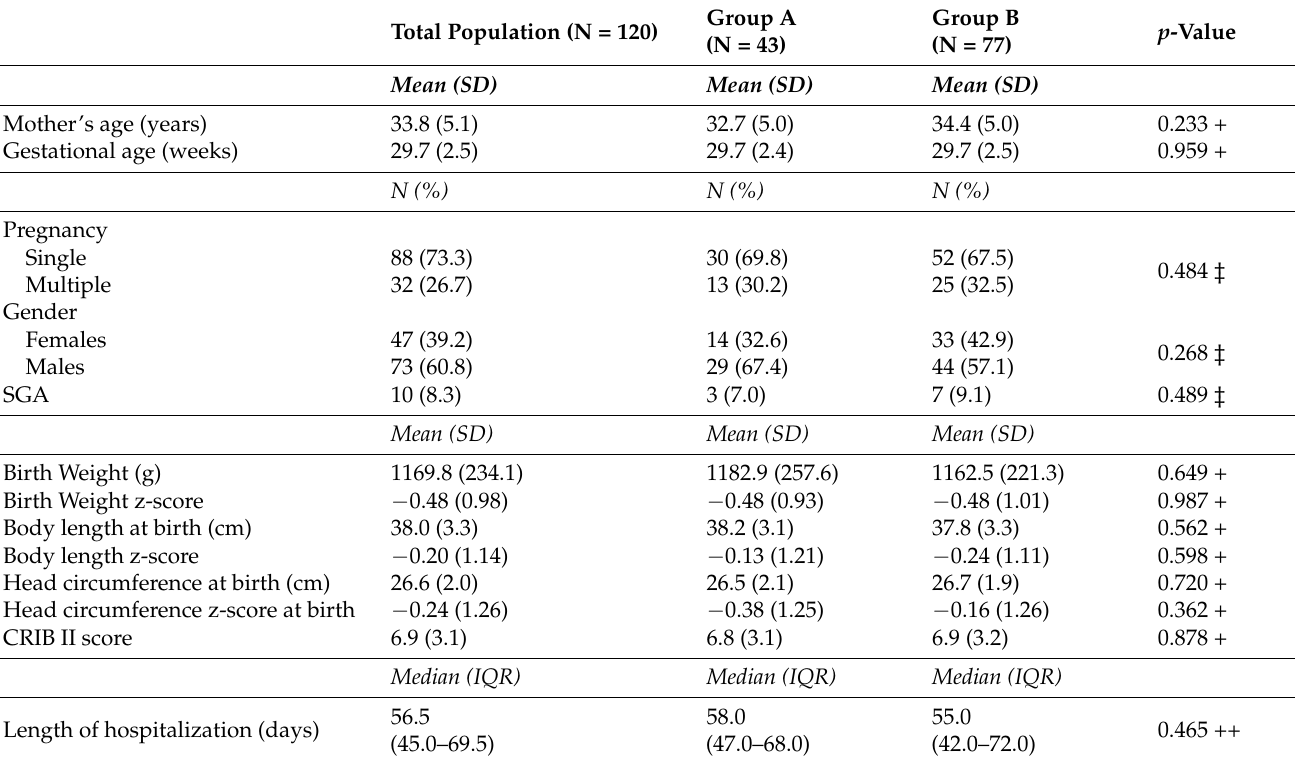
Table 1. Demographic and clinical parameters of the study population.